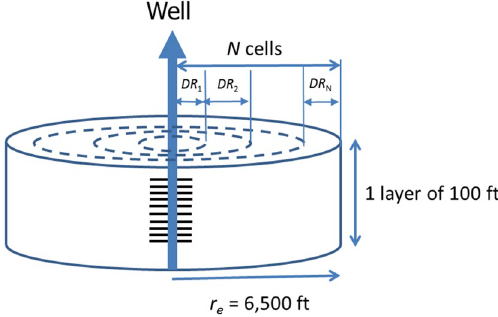
Fig. 1 General view of the radial simulation model